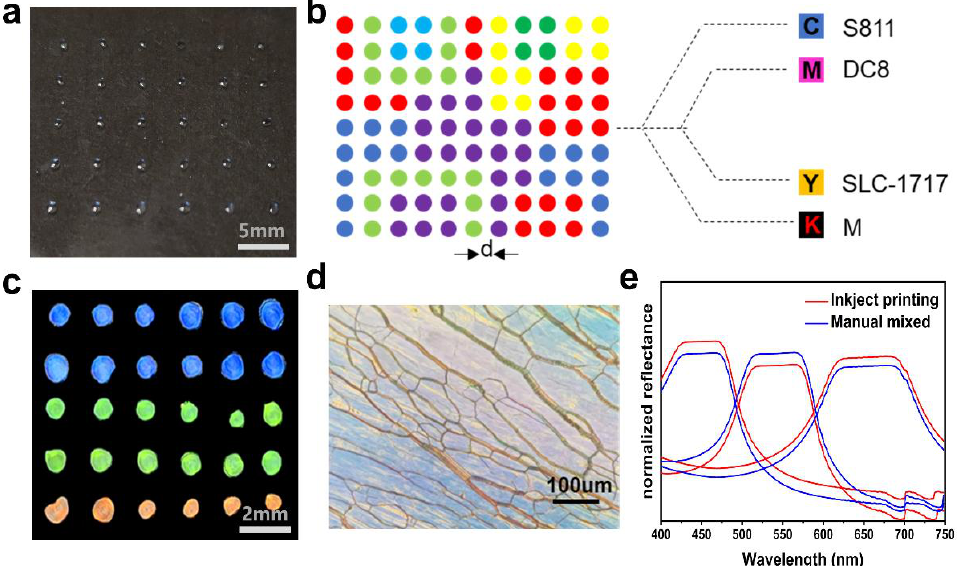
Figure 5. ( a ) Photograph of LC microdroplets prepared by inkjet printing technology. ( b ) Schematic of the regulation of LC microdroplets composition and distance. ( c ) Photograph of LC microdroplets after orientation. ( d ) Optical texture under the polarizing optical microscope after sample orientation. ( e ) The reflectance spectra of LC microdroplets were prepared by inkjet printing (red line) and manual mixed (blue line).